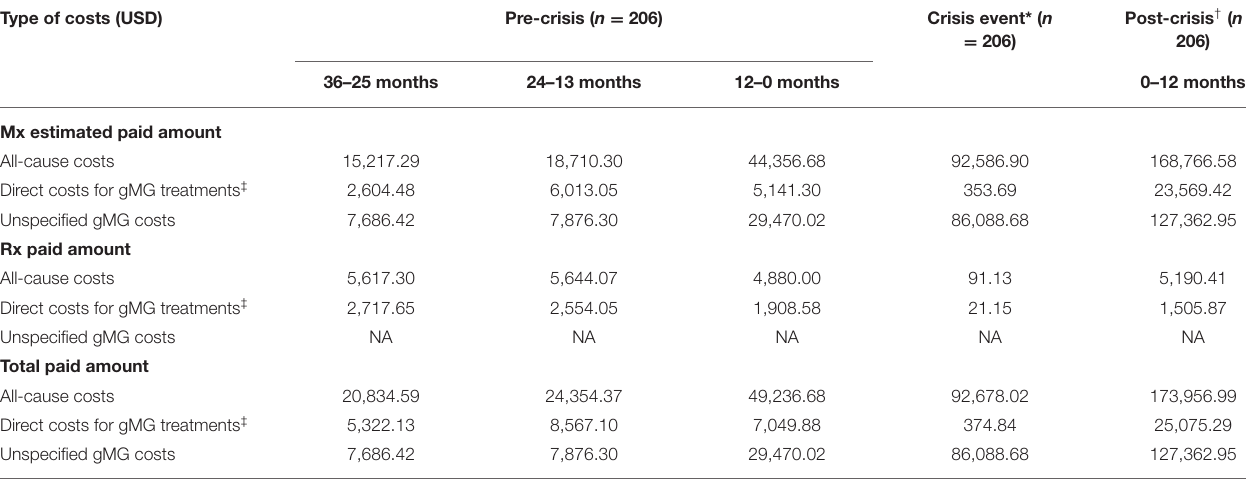
TABLE 8 | Standardized mean 12-month payer-relevant medical and pharmacy service costs per patient in the crisis event